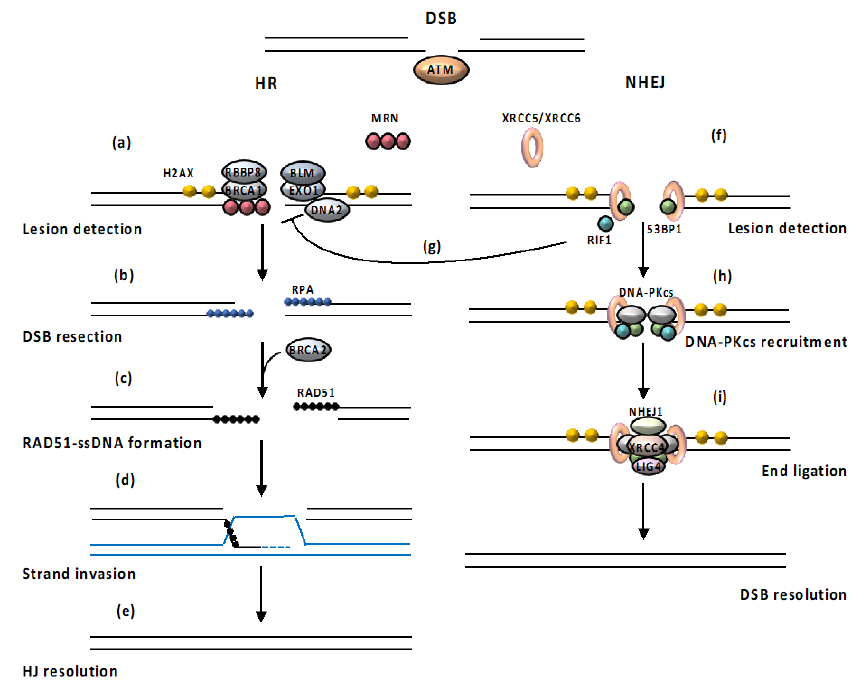
Figure 2. Mechanisms of DSB repair. (a) Following the recruitment and activation of ATM (ATM serine / protein kinase), the nuclease MRN (MRE11 (MRE11 homolog, double strand break repair nuclease) / RAD50 (RAD50 double strand break repair protein) / NBN (nibrin), along with its cofactor RBBP8 (RB binding protein 8) and other accessory proteins, such as BRCA1(BRCA1 DNA repair associated), initiates the 5′ - 3′ resection of the DNA ends, resulting in the creation of 3′ -OH ssDNA tails on both ends of the break. Next, long range resection is achieved by EXO1 (exonuclease 1), DNA2 (DNA replication helicase / nuclease 2) and BLM (BLM RecQ like helicase). (b) The ssDNA-ends are coated and stabilized by RPA (replication protein A). (c) RPA is replaced from ssDNA ends by RAD51 (RAD51 recombinase) in a BRCA2 (BRCA2 DNA repair associated)-dependent process and formation of the RAD51 multimeric filament on ssDNA occurs. (d) RAD51-ssDNA filament can then strand invade a homologous dsDNA, leading to displacement on one strand of the intact DNA duplex and formation of a D-loop. (e) Following strand exchange, the resulting Holliday junction is resolved. (f) NHEJ (Non-homologous end joining) pathway initiates with the ATM-mediated phosphorylation of 53BP1, required for the recruitment of the anti-resection proteins RIF1 (replication timing regulatory factor 1) to the DSBs (double strand breaks) and inhibition of DNA resection (g). 53BP1 (TP53 (tumor protein p53)-binding protein 1) promotes the binding of XRCC5 / XRCC6 (X-ray repair cross-complementing protein 6 and 5) heterodimer to the two ends of the DSB. (h) DNA-PKcs (DNA-dependent protein kinase catalytic subunit) acts as a sca ff old protein that tethers the broken ends together. (i) The LIG4 (DNA ligase 4) / XRCC4 (X-ray repair cross complementing 4) / NHEJ1 (non-homologous end joining factor 1) complex ligates the DNA ends. Black arrows ( ↑ ) and perpendicular lines ( ⊥ ) indicate activation and repression,